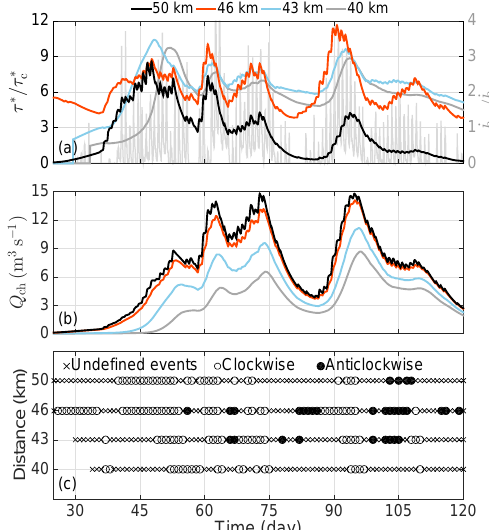
Figure 12. Hysteresis between water discharge and transport stage for simulation T_2008 (see Table 4 and Fig. 6). Time series at four locations (km 40, 43, 46, and 50) distributed over the last 10km of the glacier profile of (a) transport stage ( τ ∗ /τ ∗ c ) and normalized water input ( ˙ b ca / ˙ b ssmax ) at the terminus (light grey); (b) discharge in the channel, Q ch ; and (c) calculated direction of the daily hys- teresis when transport stage is plotted against water discharge. The hysteresis is clockwise when transport stage peaks before discharge over a daily cycle. Undefined events represent days where the fluc- tuations in transport stage or discharge are either simultaneous or not strong enough to produce hysteresis.